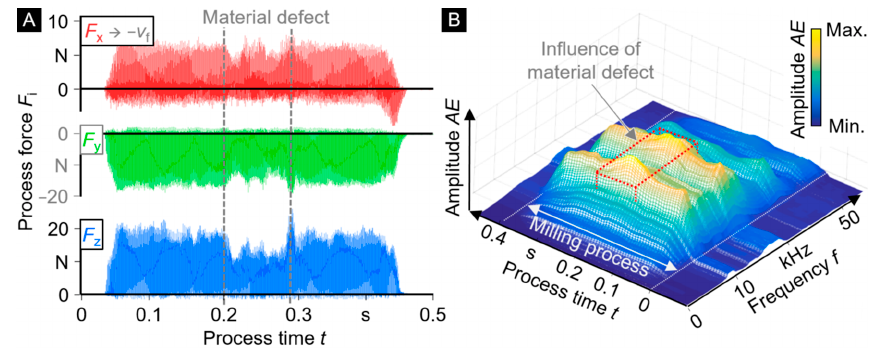
Figure 2. Cutting forces ( A ) and acoustic emission ( B ) influenced by a material defect.